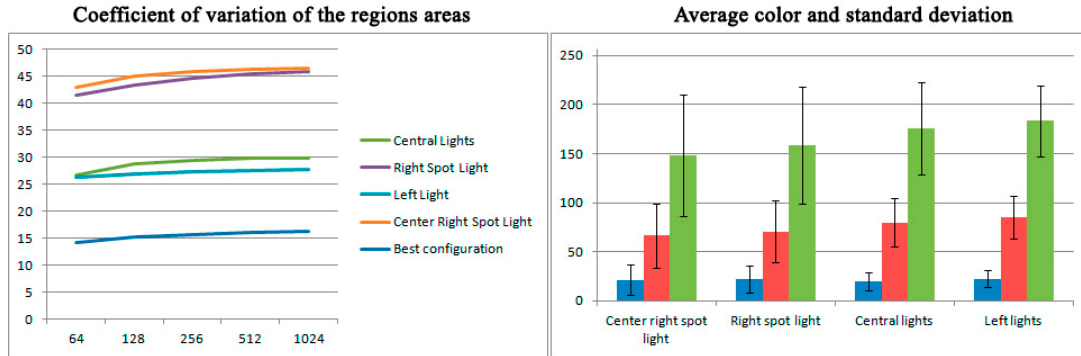
Figure 13 . Results of the four performed tests. Figure 13. Results of the four performed